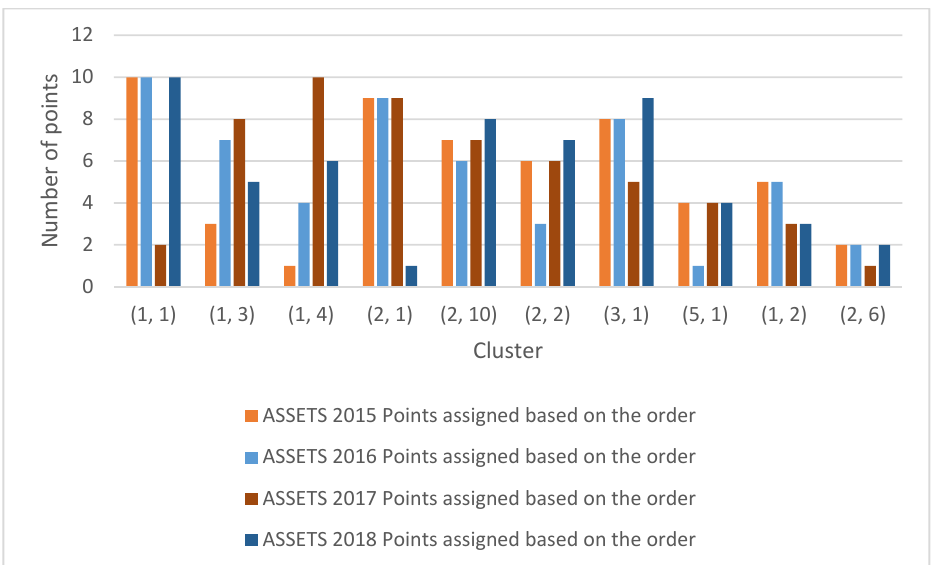
Cluster ASSETS 2015 Points assigned based on the order ASSETS 2016 Points assigned based on the order ASSETS 2017 Points assigned based on the order ASSETS 2018 Points assigned based on the